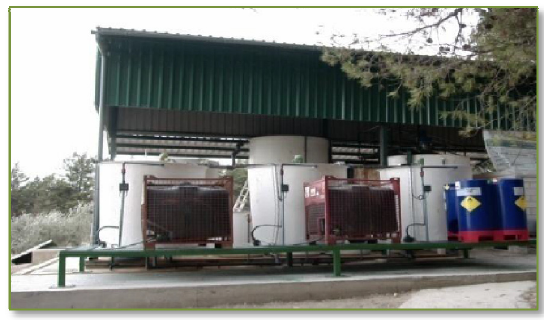
Figure 2. The secondary treatment plant set-up in an olive oil mill located in Jaén